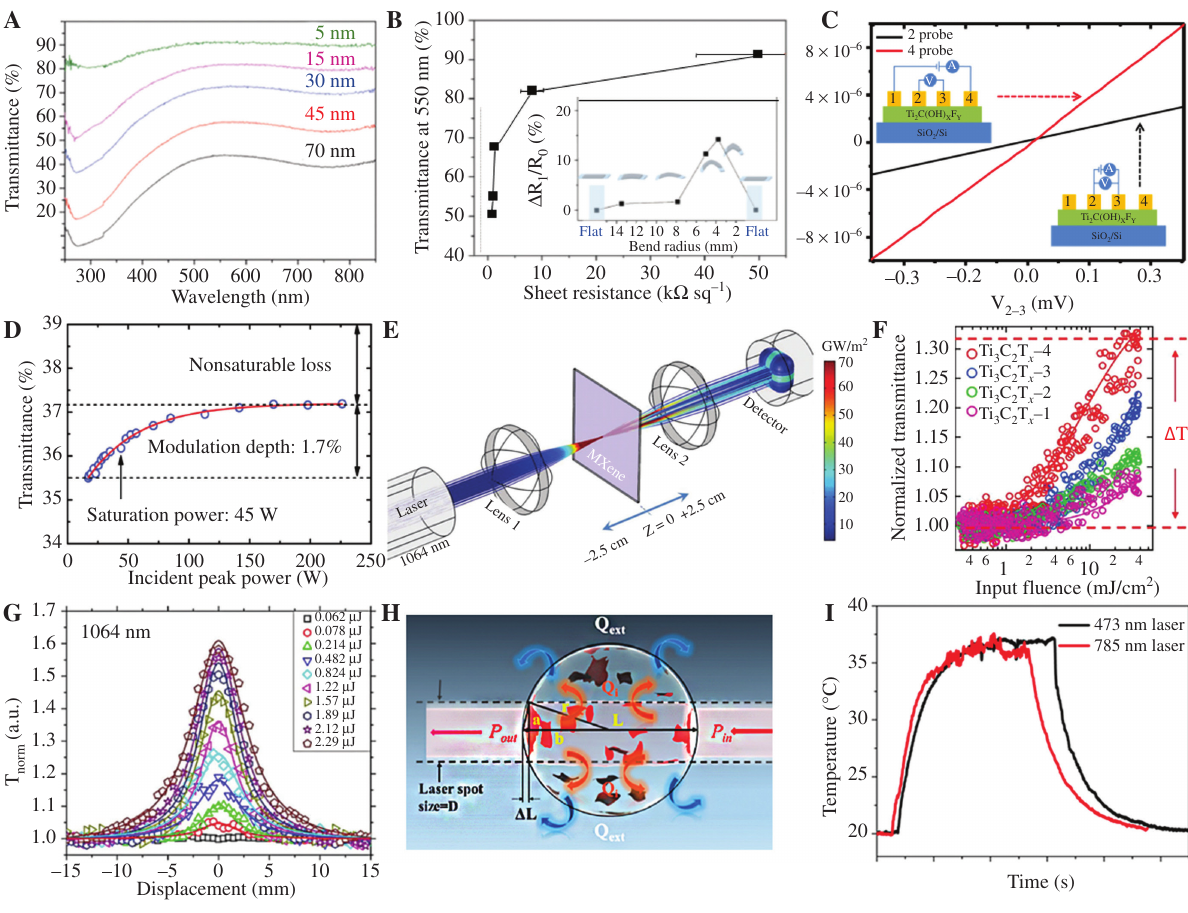
Figure 7: Optoelectronic properties of MXenes. (A) UV-vis spectra of spray-coated Ti of sheet resistance. Inset shows bending characterizations of spray-coated Ti conductance of single Ti measurement. (D) Nonlinear energy-dependent transmission curve of side-polished fiber with Ti aperture Z-scan method. Laser density is controlled by z position. (F) Nonlinear transmittance of Ti Open aperture Z-scan characterizations of position-dependent nonlinear transmittance of Ti with laser illumination. (I) Time-resolved temperature profile of Ti